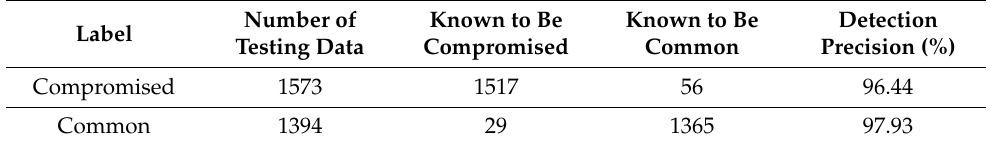
Table 4. Expressed detection